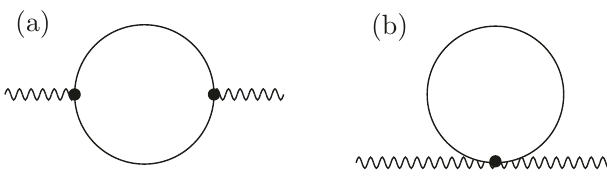
h µν h αβ due to a quantum matter field h i